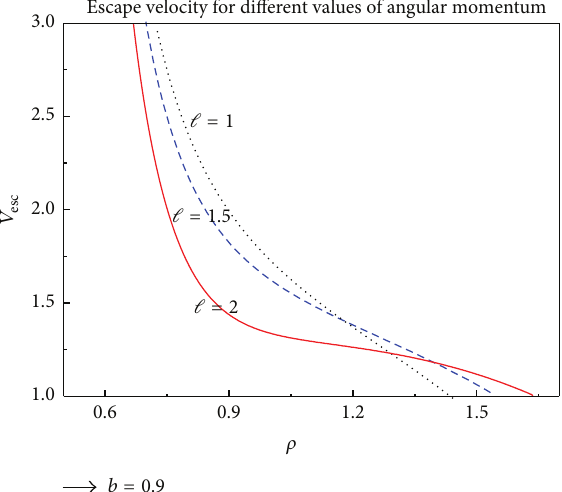
Figure 11: Escape velocity ( V esc ) against 𝜌 for different values of angular momentum ℓ , for extremal